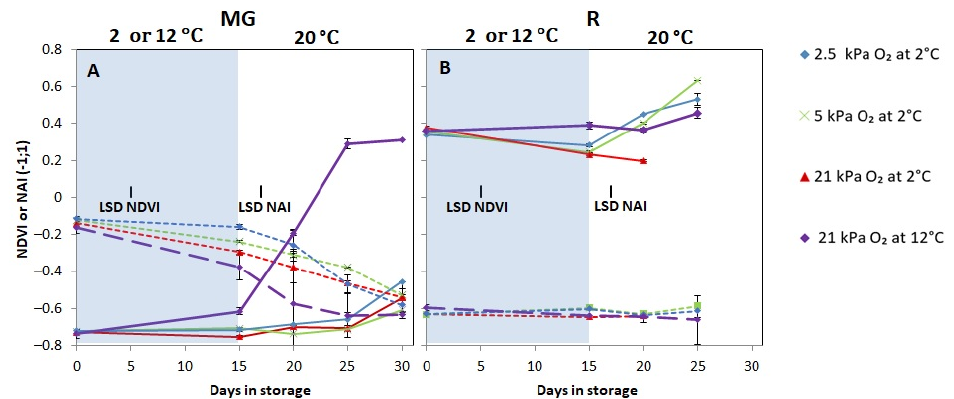
Figure 4. Colour as indicated by NDVI (dotted lines) and NAI (full lines) index of MG ( A ) and R ( B ) tomatoes during cold storage at 2 or 12 °C (blue area) and subsequent shelf-life at 20 °C (white area). Blue, green, red and purple lines and symbols indicate 2.5, 5, 21 kPa O 2 (low oxygen control) applied during storage at 2 °C and 21 kPa O 2 at 12 °C (temperature control), respectively. The NDVI or NAI with indicated standard error is shown for five individual tomatoes (repeated measure over times). LSD values ( p < 0.05) are indicated per panel.